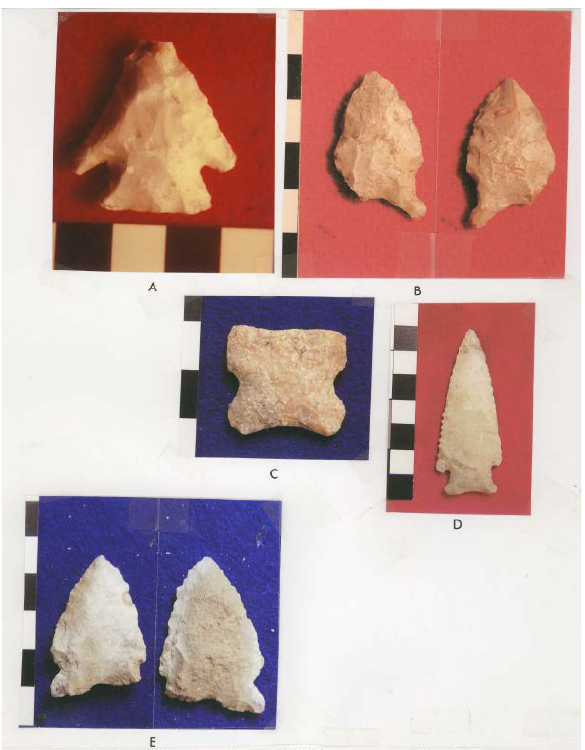
Figure 7. Projectile points relating to the Hensler Site. ( A ) A Thebes point recovered from the adjacent Yelk Site, a quarry-workshop site destroyed by modern quarrying. These points are dated between 8000 and 6000 B.C; ( B ) A Dalton projectile point, also recovered from the Yelk Site. These points date to between 8500 and 7900 B.C; ( C ) Basal part of a large Side-notched Point Tradition specimen excavated from the bottom of the Hensler deposits. These points date from between 8000 and 6000 B.C; ( D ) A Hardin Barbed projectile point excavated from the lower strata of the Hensler excavations. These points